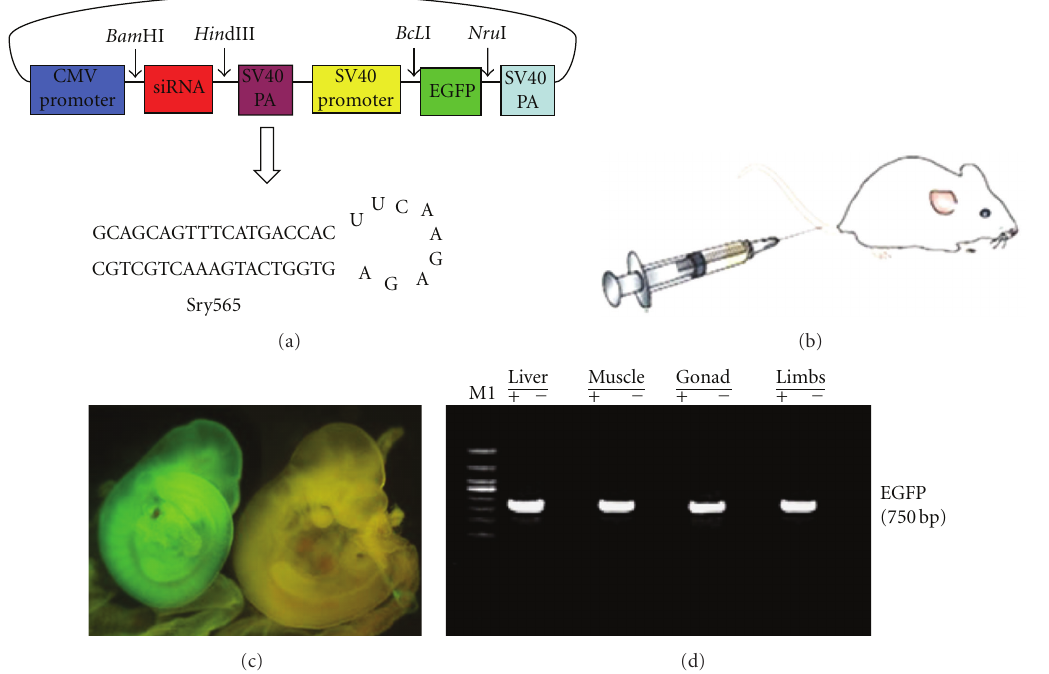
Figure 1: Schematic diagram of designing shRNAs expression vectors, and expression of siRNAs in embryos of pregnant mice. (a) Construction of shRNA expression plasmids. pSilencer4.1-CMV/neo vector was used as basic plasmid to construct the siRNA expression, plasmids pSilencer4.1/Sry565. The EGFP coding region was obtained from the pEGFP-N3 vector and cloned downstream of the SV40 promoter to replace the Neomycin gene to construct the plasmid. Gene-specific shRNAs (Sry565) or scrambled shRNA (not shown) were then ligated downstream of the CMV promoter. (b) Tail vein injection. The shRNA expression plasmids were delivered into pregnant mice though tail vein injection. (c) 11.5 dpc embryos were dissected from the uterus, and deciduas and membranes were removed. Transmitted light and fluorescence images of embryos were recorded using a Nikon-inverted fluorescence microscope to determine the extent of GFP expression. The left embryo was injected with pSilencer4.1/Sry565. The right embryo was injected with 5% glucose solution. (d) Analysis of EGFP expression in 11.5 dpc embryos. Semiquantitative RT-PCR was used to detect the GFP expression in di ff erent tissues, including liver, muscle, gonad, and limbs, in the absence ( − ) or presence of (+)